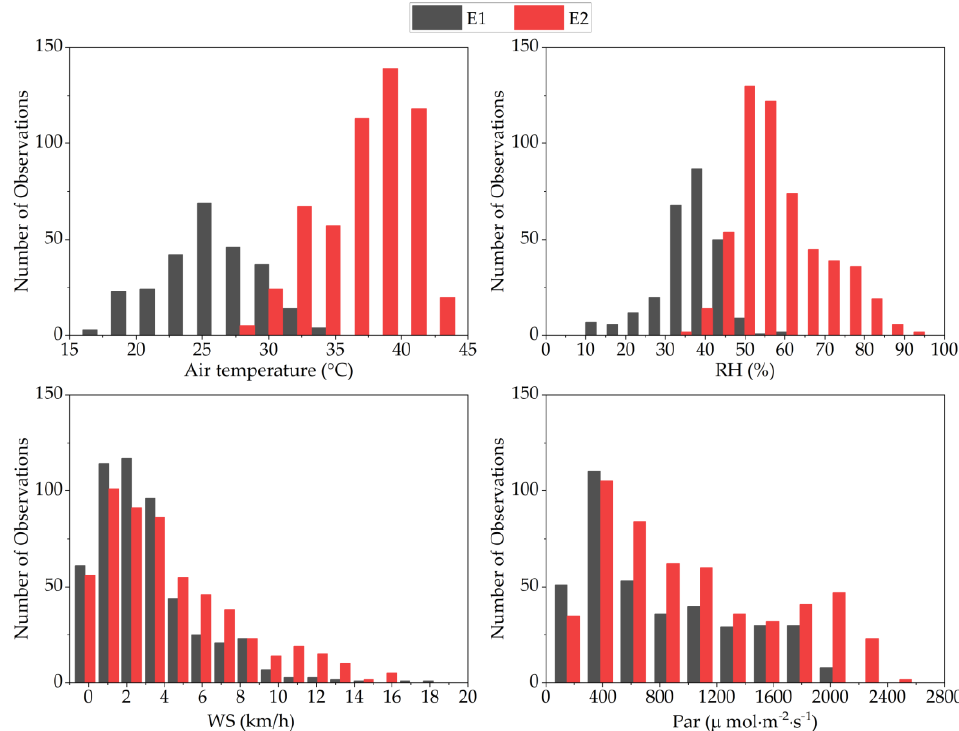
Figure 4. The histograms of climatic characteristics in two experiments.